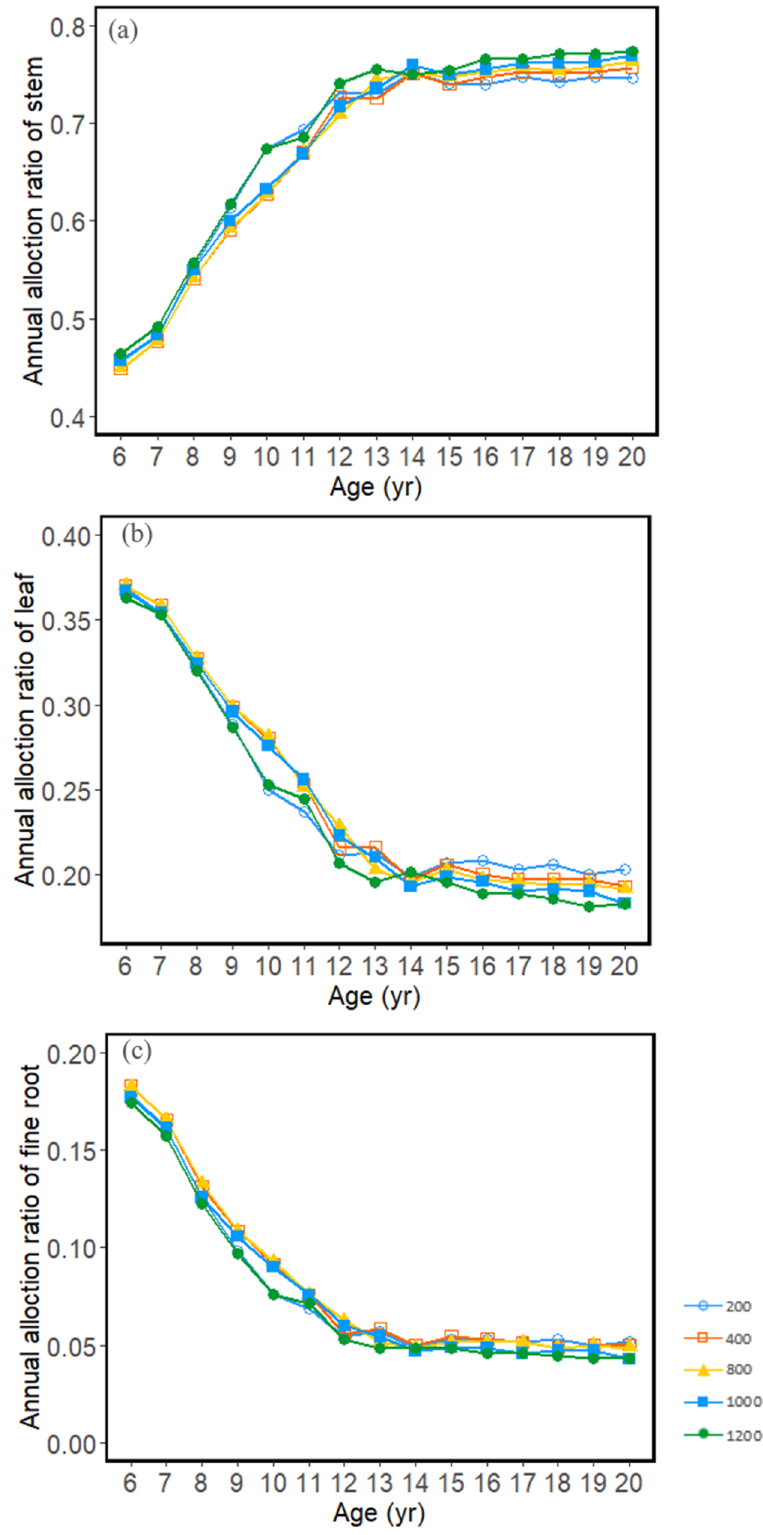
Figure 3. Changes in the annual carbon allocation ratios to the stem ( a ), foliage ( b ), and fine root ( c ) with age under different stand densities (200, 400, 800, 1000, and 1200 stems ha − 1 ) using the modified model.